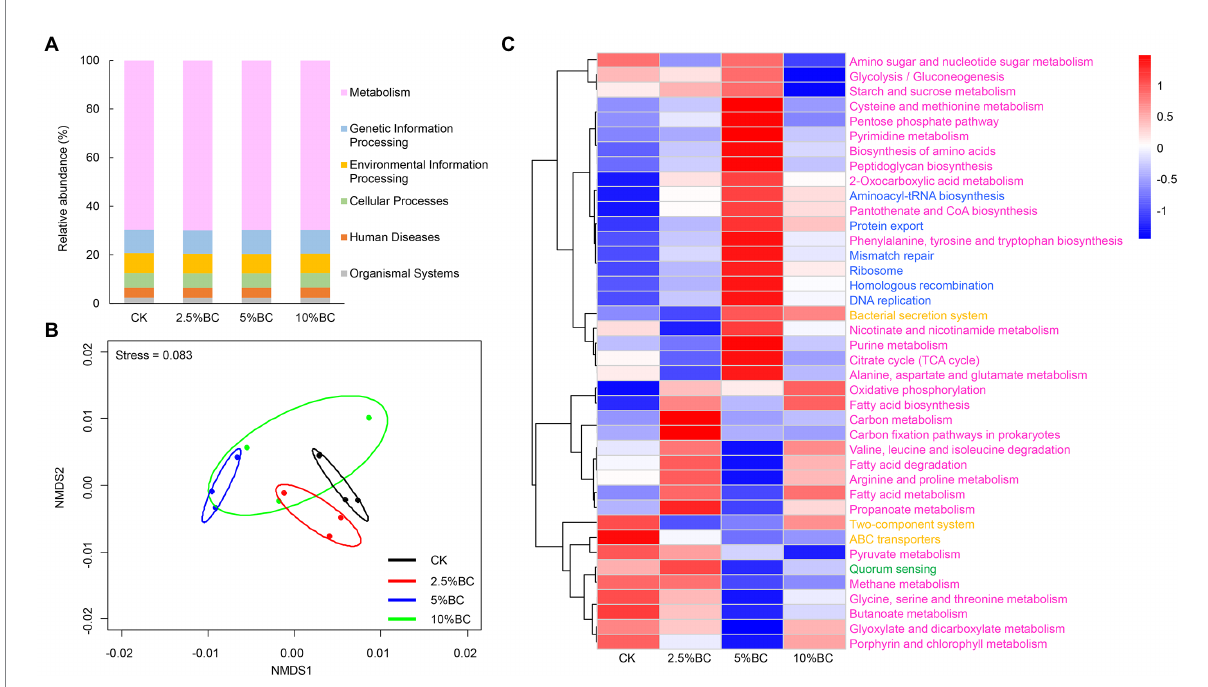
FIGURE 3 Effect of biochar on bacterial metabolic function profiles of the compost analyzed by PICRUSt. (A) Relative abundance of six function categories. (B) NMDS ordination plots of bacterial function composition in different treatments based on the Bray-Curtis distance similarity. (C) Heat map showing the relative abundance of the top 40 functional gene families predicted by PICRUSt. Gene families are colored by functional categories. CK, compost without biochar; 2.5%BC, compost added with 2.5% (w/w) biochar; 5%BC, compost added with 5% (w/w) biochar; 10%BC, compost added with 10% (w/w)